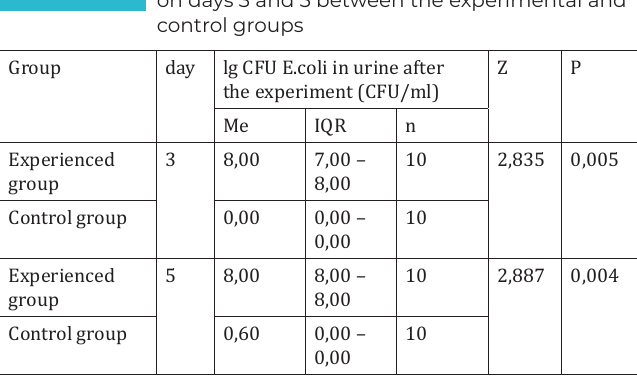
Comparative analysis of lg CFU E.coli in urine on days 3 and 5 between the experimental